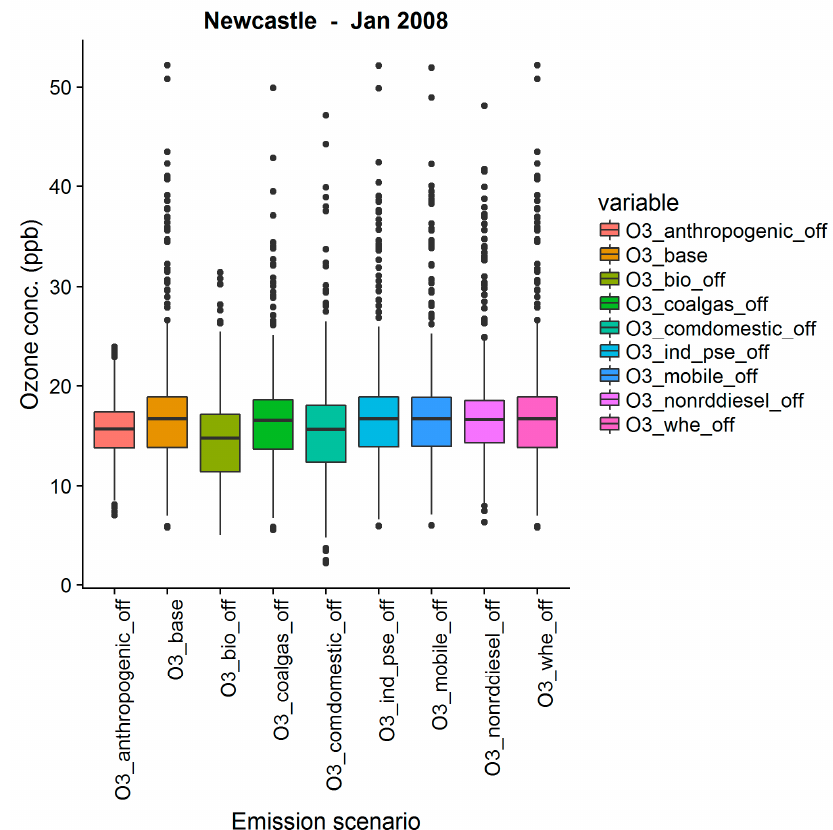
Figure A10. Box plot for 1-h ozone concentration (ppb) in January 2008 under different emission scenarios at Newcastle.